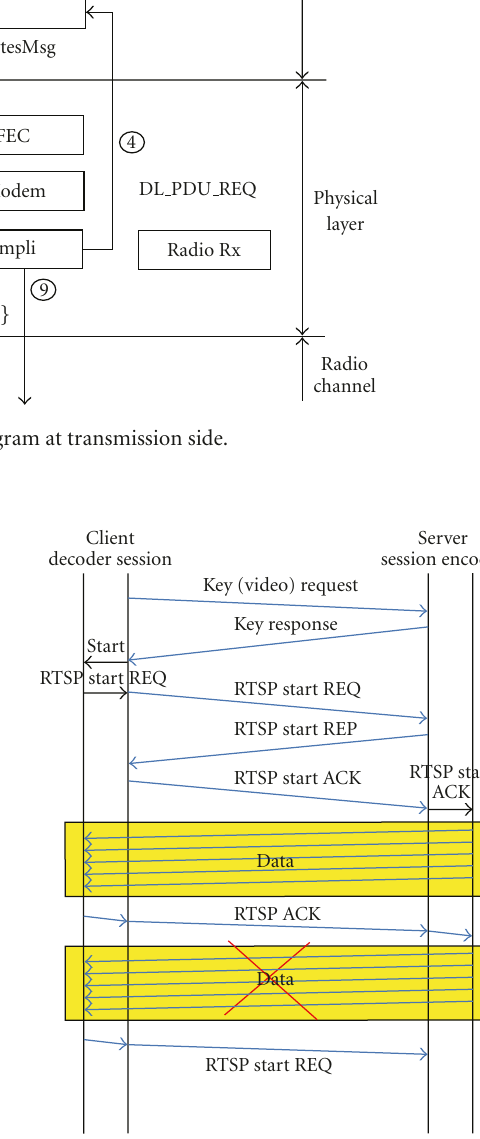
Figure 7: Video session establishment sequence